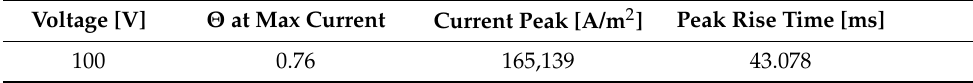
Table 3. Max current density and peak rise time for 100